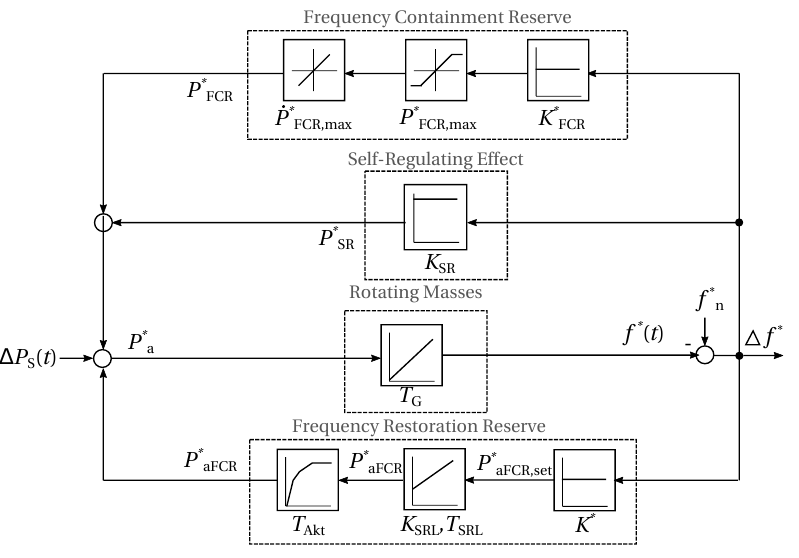
Figure 7. Block diagram of the dynamic ENTSO-E grid